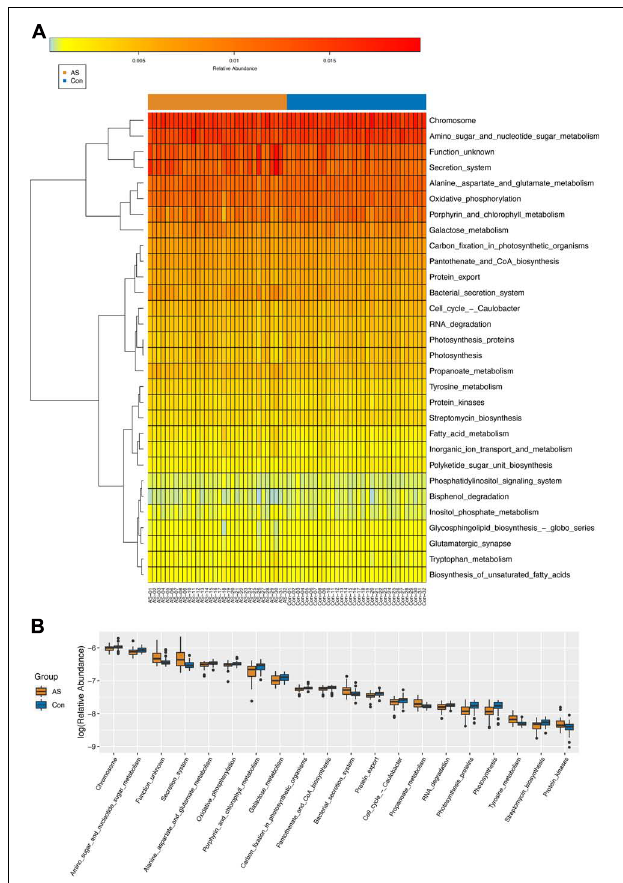
FIGURE 4 | KEGG pathways (level 3) predicted by PICRUSt. (A,B) Differential KEGG pathways with top relative abundance were visualized as heatmap and box plot. Warmer color indicates higher relative abundance, whereas colder color indicates lower relative